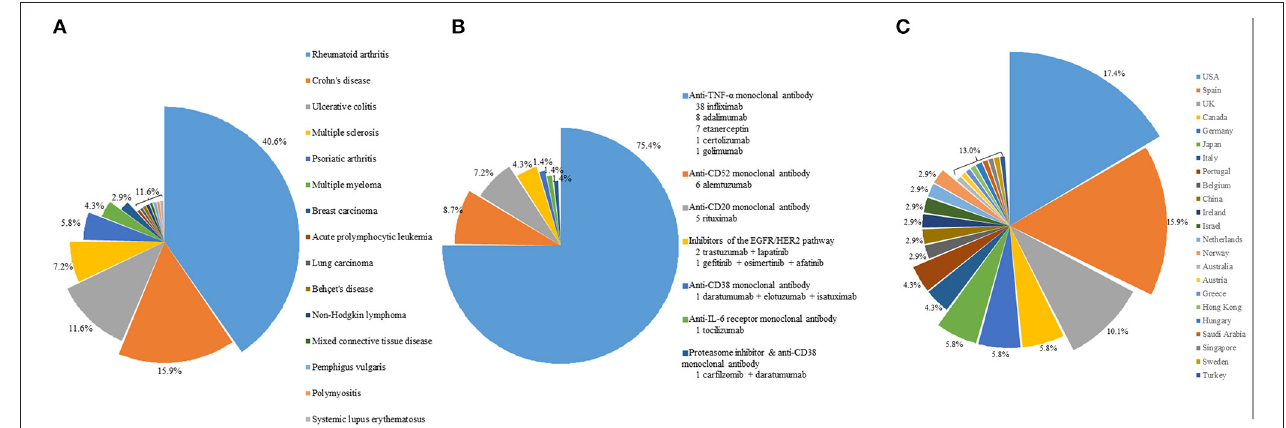
FIGURE 1 | (A) Distribution of underlying diseases in patients on targeted therapy with listeriosis. (B) Distribution of the type of targeted therapy in these patients. (C) Distribution of these patients with listeriosis in different countries or regions.